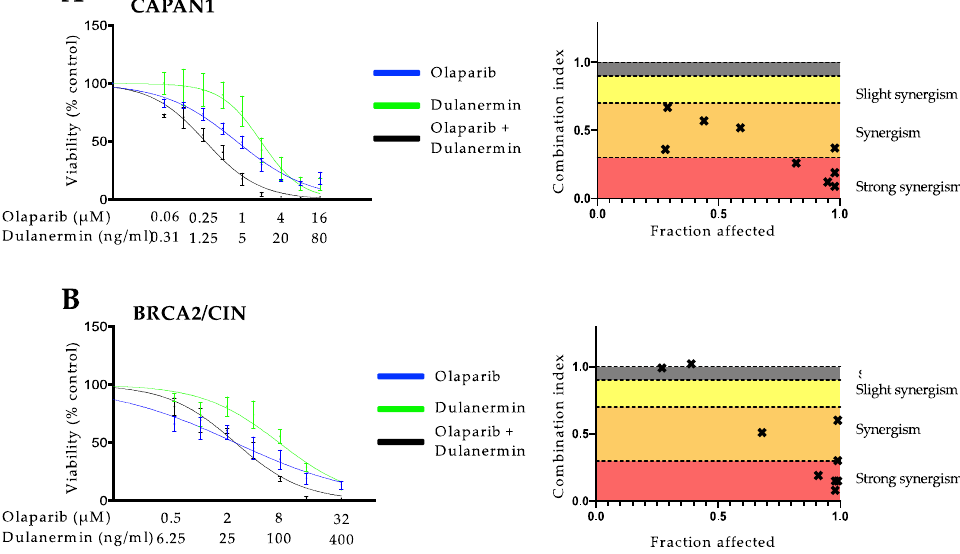
Figure 3. Combined olaparib and the clinically tested TRAIL targeting compound dulanermin syn- ergize in pancreatic cancer cells independently of BRCA2 status. Proliferation assays of the effects of olaparib, dulanermin, or their combination on BRCA2 deficient CAPAN1 ( A ) and BRCA2/CIN ( B ). Cells were treated for 6 days with the indicated agents and subsequently analyzed via SYBR green proliferation assay. All experiments were performed in triplicate with error bars representing SEM from three independent experiments. Drug interactions were analyzed using the Chou–Tala- lay method with a combination index (CI) of <1, 1, and >1 indicating synergistic, additive, and an- tagonistic drug effects, respectively. In the combination index graphs, dots depict the CI at the re- spective fraction of cancer cells affected (x-axis, 0.0 = no cells dead, 1.0 = all cells dead).